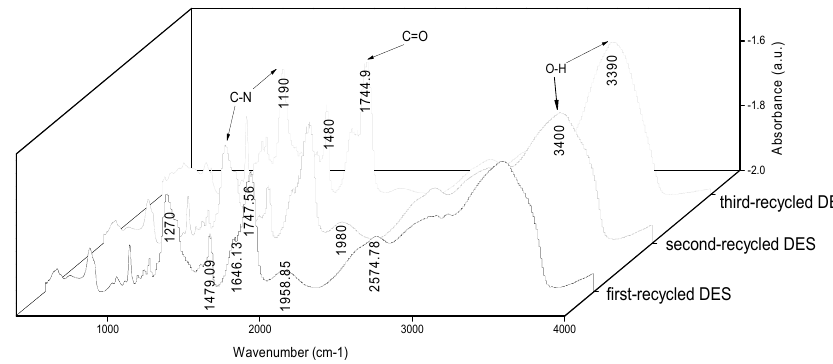
Figure 3. IR spectrum of multiply recycled DES.